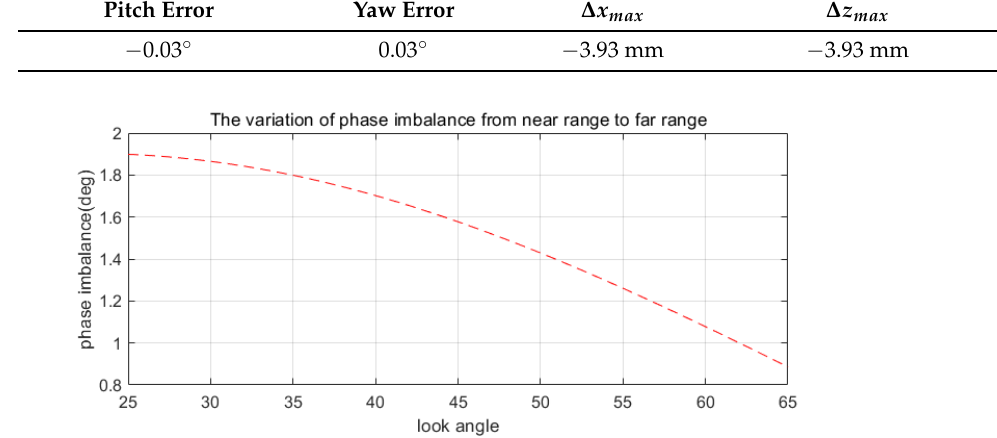
Figure 4. The change of phase imbalance in range caused by maximum attitude control errors of